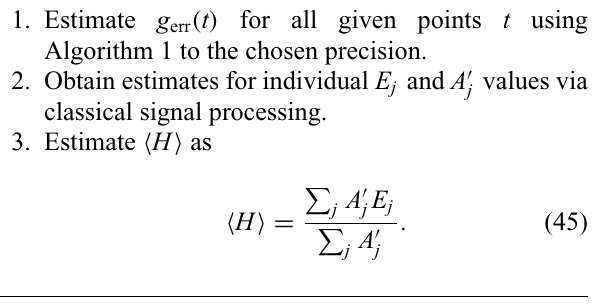
Algorithm 3. Verified expectation value